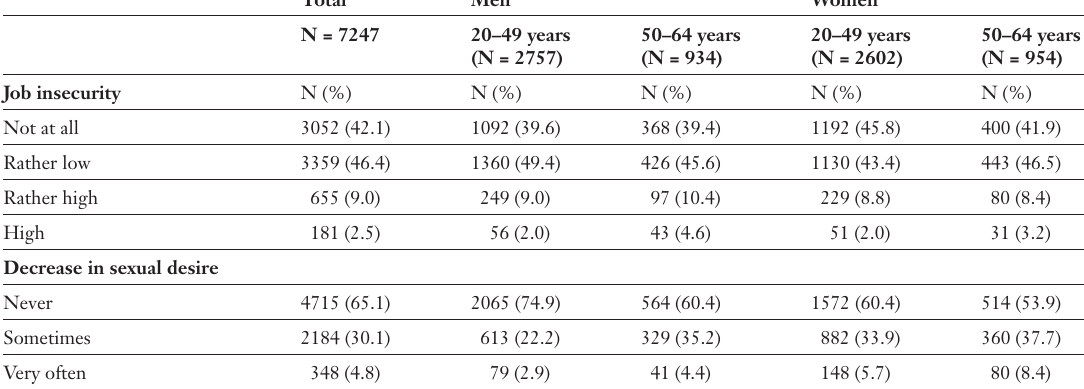
Crude prevalence rates of job insecurity and decrease of sex- ual desire for total population and strati- fied by sex and